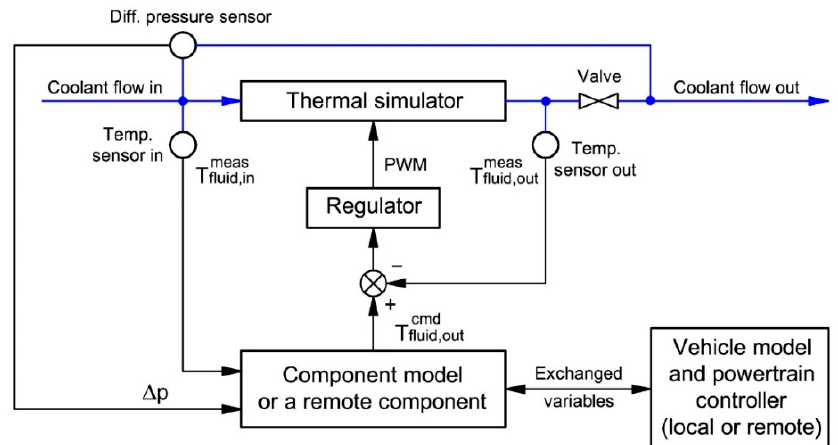
Figure 9. Operating and control loops of a physical simulator representing an electric drive component.